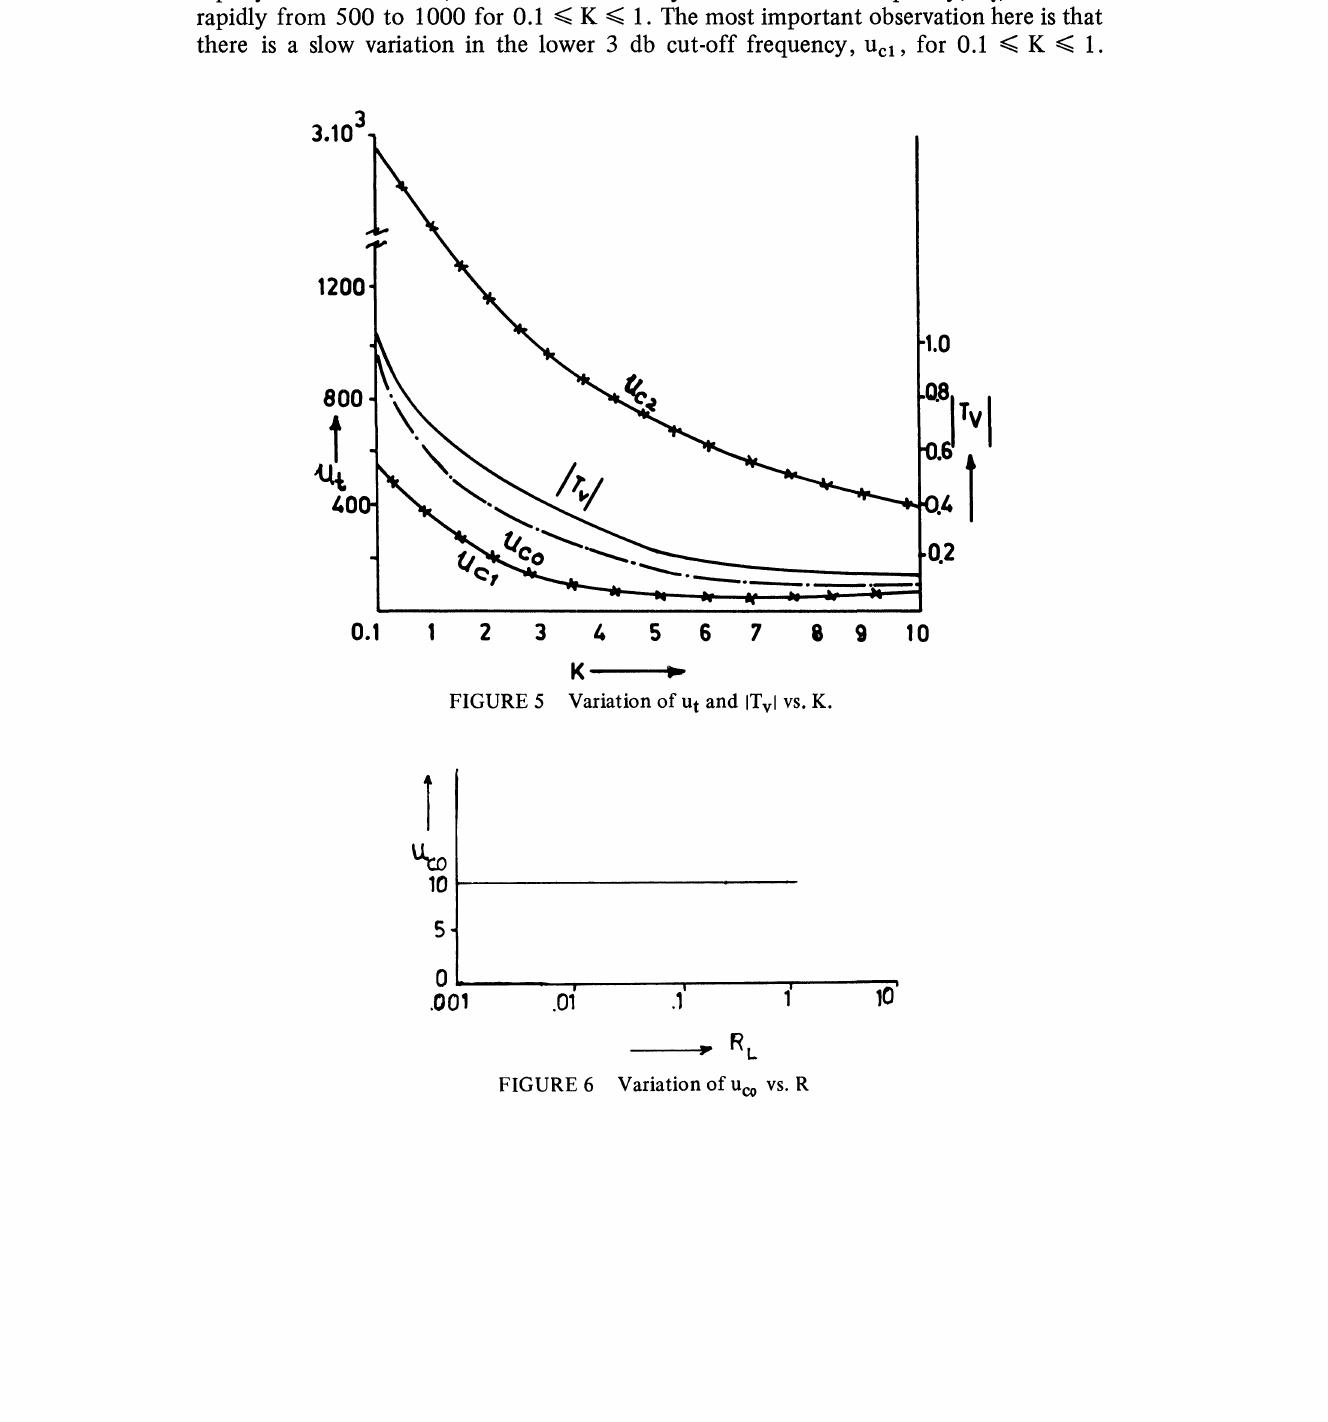
FIGURE 6 Variation Of Uc0 vs.